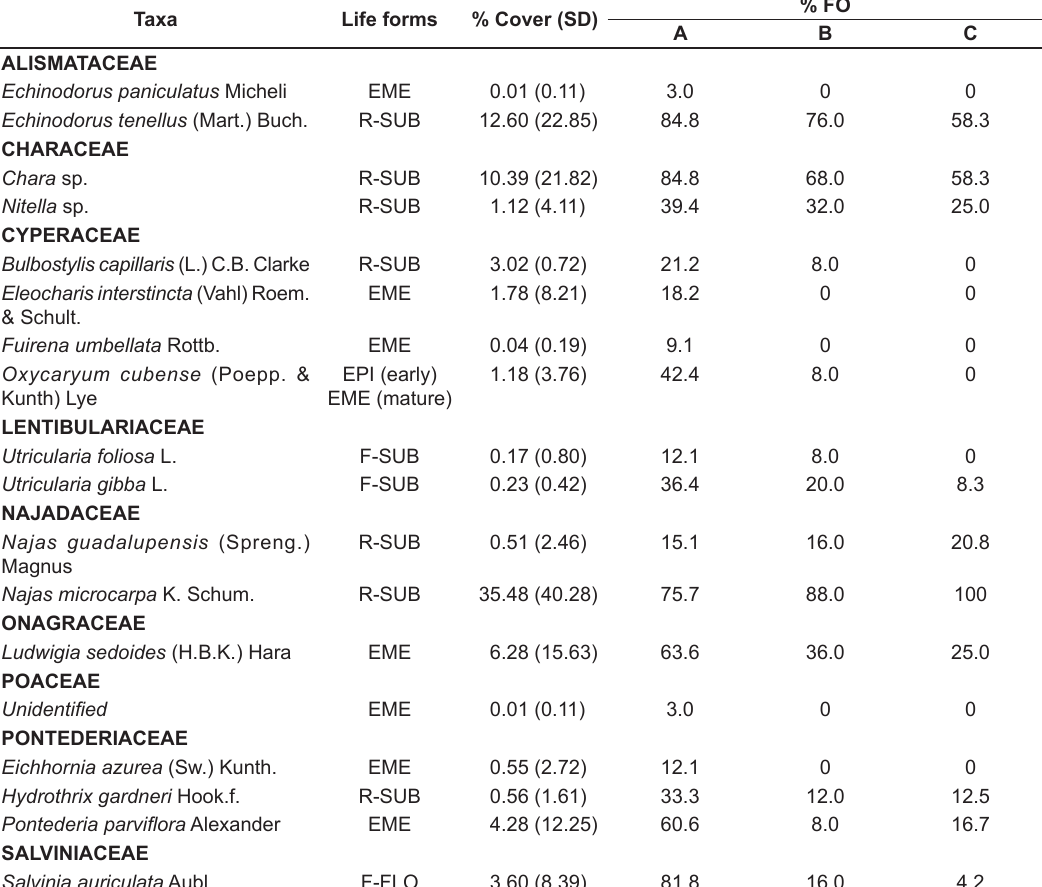
Table 1. Aquatic macrophytes recorded along depth gradients in Lajeado Reservoir, their respective life forms, mean abundance (% Cover and standard deviation), and frequency of occurrence (% FO) in the sections A, B, C. Life Forms: EME = emergent; R-SUB = rooted submerged; F-SUB = free submerged ; EPI = epiphytic; F-FLO =